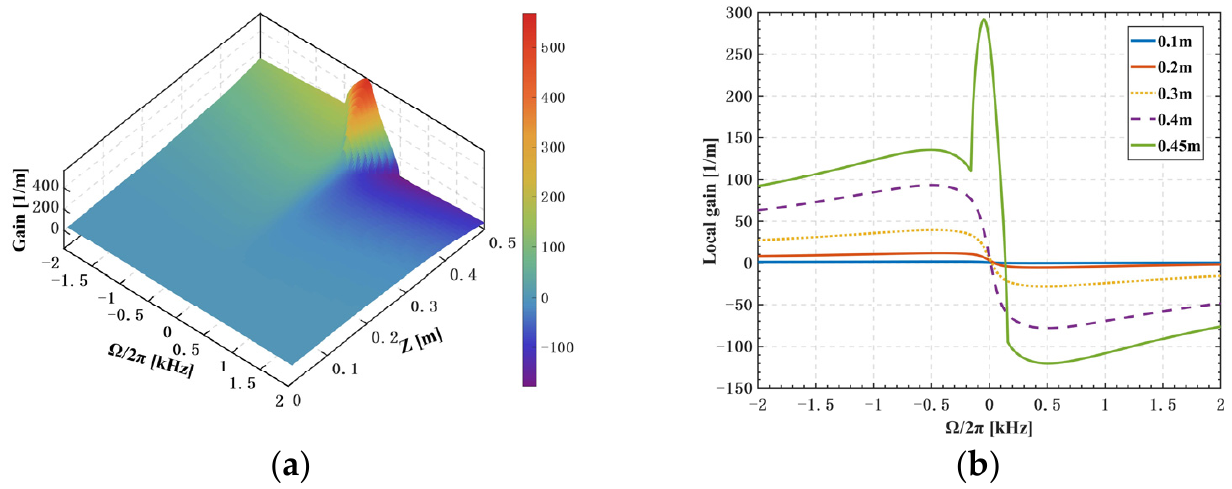
Figure 1. ( a ) The local gain as a function of frequency shift and fiber length, ( b ) the gain at different position of fiber of 0.1, 0.2, 0.3, 0.4, and 0.45 m.